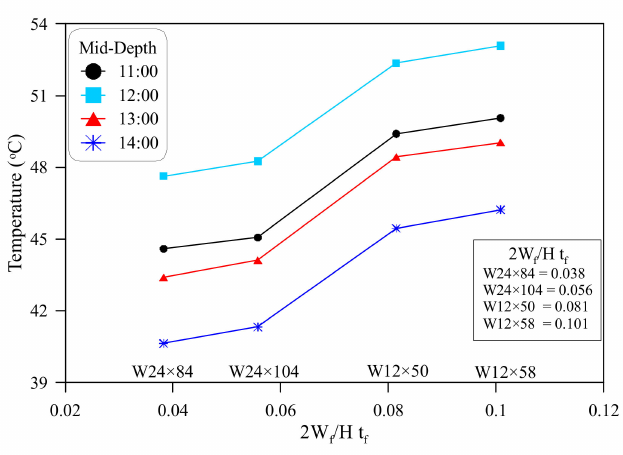
Figure 11. Relationship between mid-depth temperature 2 W f / Ht f at noon